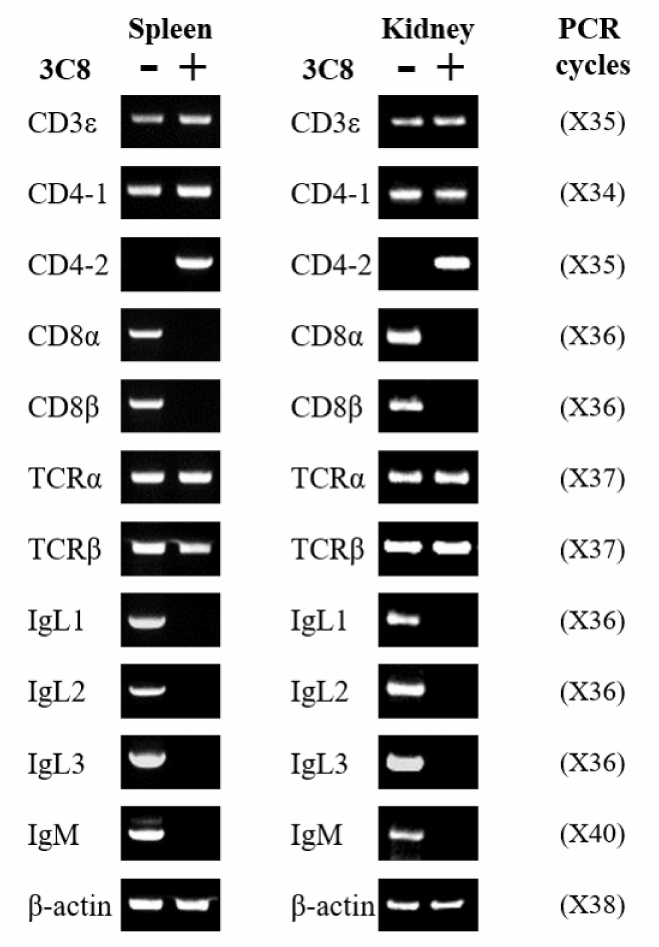
Figure 3. Gene expression profiles of the cell marker genes in flow-sorted spleen lymphocytes and head-kidney lymphocytes. Specific oligonucleotide primers for T cell and B cell gene expression were employed for RT-PCR and β -actin was used as the housekeeping gene. Numbers in parenthesis indicate PCR cycles. -; mAb 3C8-negative lymphocytes, + ; mAb 3C8-positive